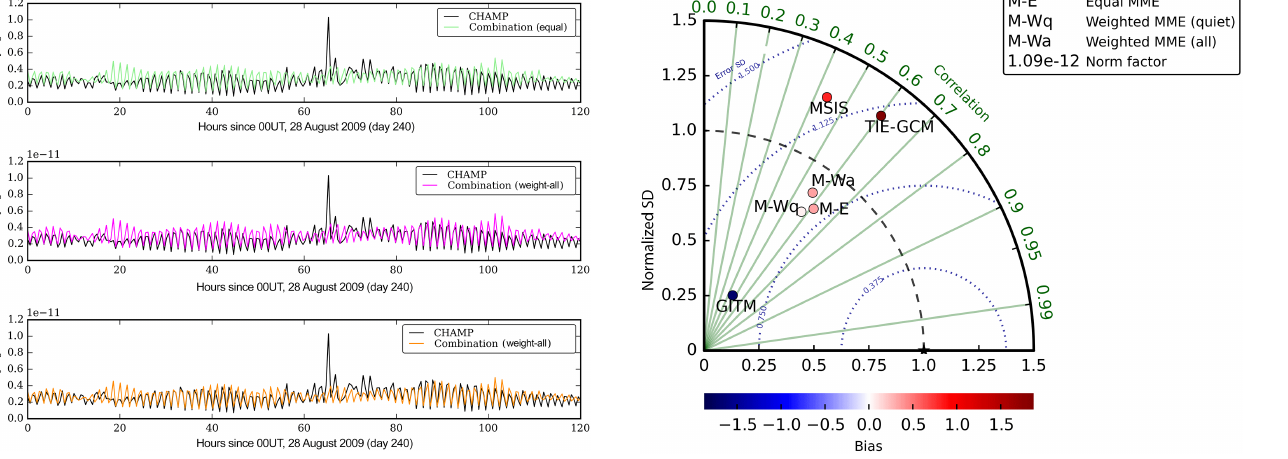
Figure 6. Neutral density values of the three MMEs for the first test scenario, equally weighted, quiet-time weighted, and all-times weighted.